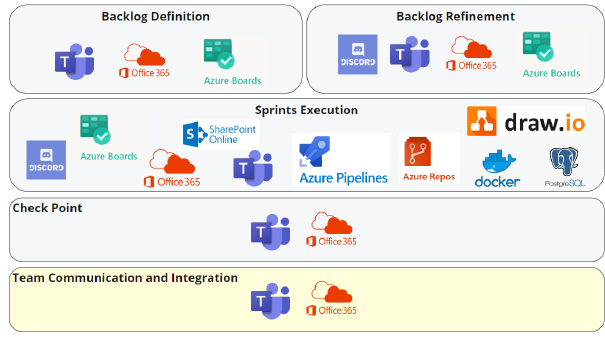
Figure 4. Case 2 process